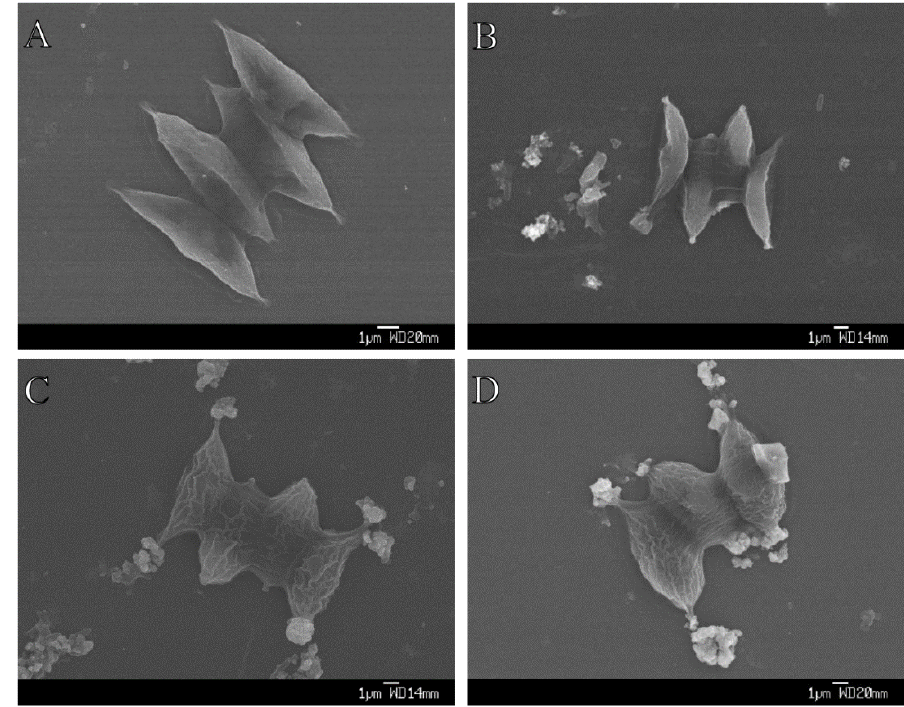
Figure 4. Aggregation between S. obliquus and three sizes of TiO 2 after 72 h exposure. ( A ) Control; ( B ) Bulk TiO 2 ; ( C ) 50 nm TiO 2 ; and ( D ) 10 nm-TiO 2 .